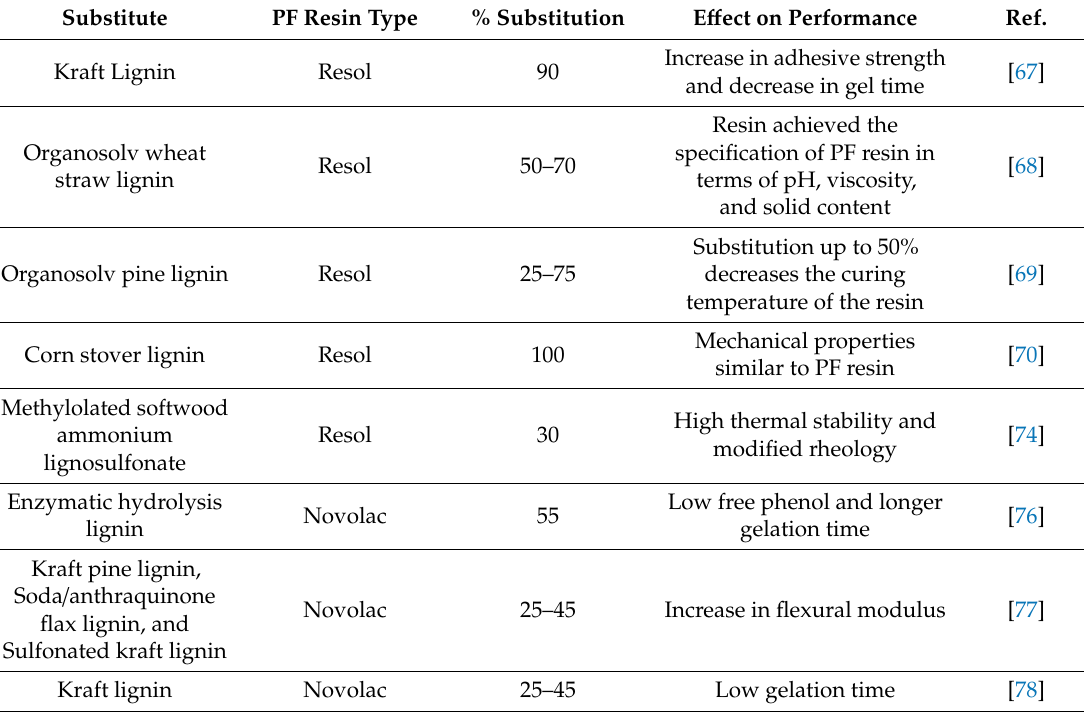
Table 1. Examples of lignin substituted PF